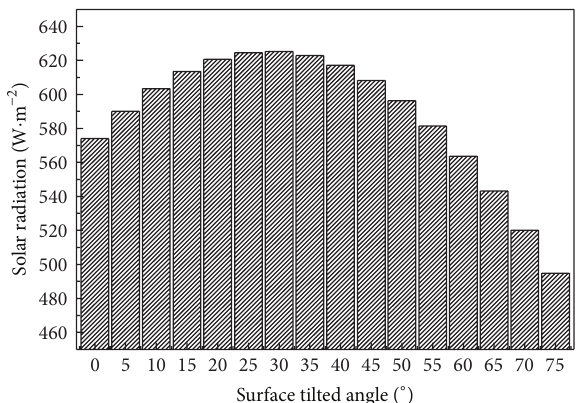
Figure 3: Annually average solar radiation for tilted